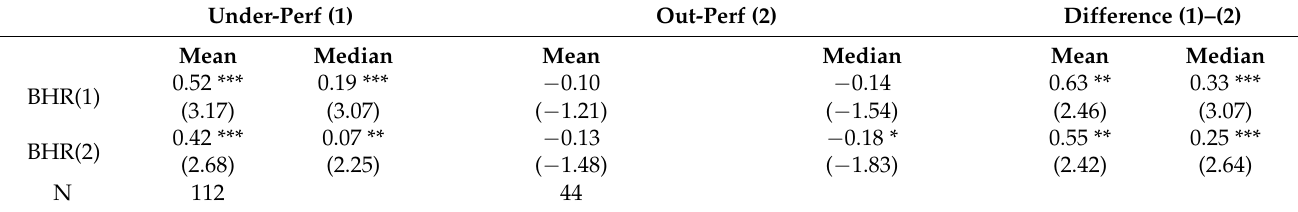
Panel C: BHAR for the Forced Sample, CEO Fired for Business Misconducts